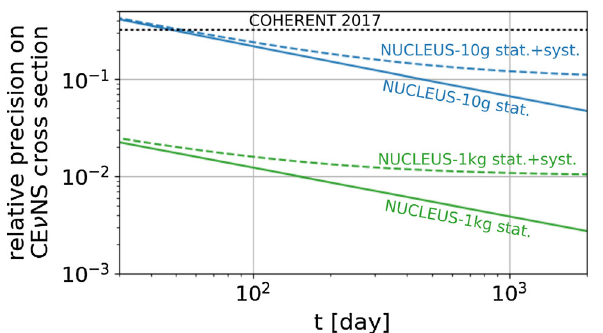
Fig. 12 Relative precision of the CE ν NS cross-section measurement as a function of live time for the experimental stages NUCLEUS- 10g (composed of CaWO 4 and Al 2 O 3 detectors), and NUCLEUS-1kg (modeled as a Ge detector array). The solid lines show statistical uncer- tainties (one standard deviation) only, for the dashed lines a system- atic uncertainty of 10% (1%) is added in the case of NUCLEUS-10g (NUCLEUS-1kg). The dotted horizontal line indicates the 32% preci- sion achieved by COHERENT (adding in quadrature the 16% experi- mental uncertainty and the 28% uncertainty of the rate prediction